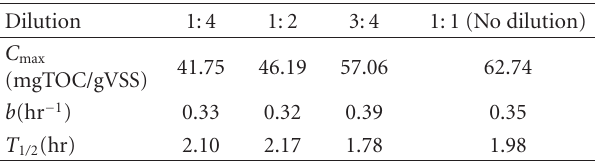
Table 3: Estimation of C max , b , and T 1 / 2 using (2) and (3) for the di- lution of raw sludge sample.